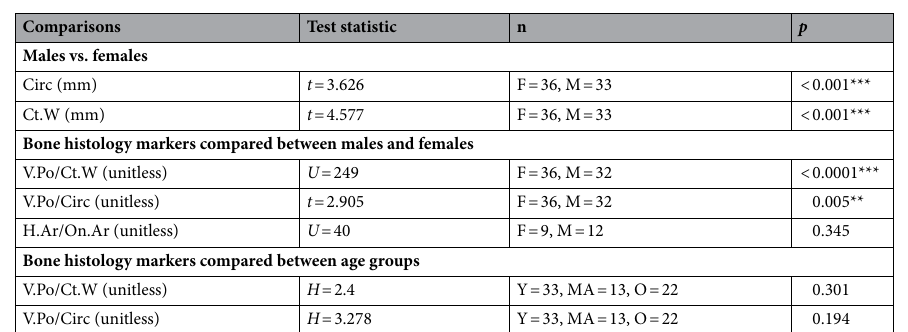
Table 3. All results of inferential analyses comparing femoral size, and statistically significant results of bone histological markers compared between the sex and age groups. V.Po density of canals/pores per mm 2 , H.Ar/ On.Ar ratio of Haversian canal to osteon area in µm 2 , OPD osteon population density per mm 2 , t independent